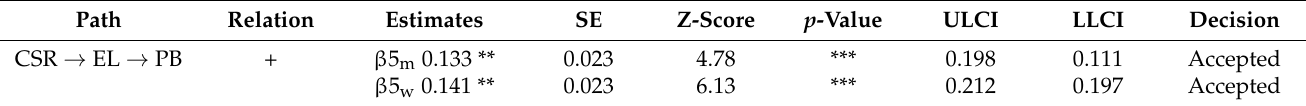
Table 7. Moderation effect of leadership (male vs. female) for